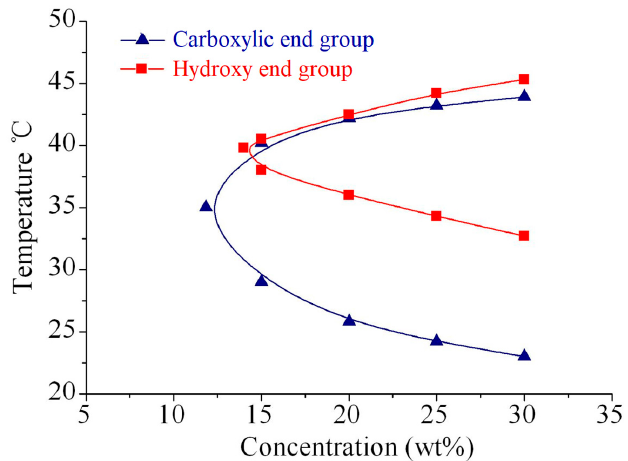
Figure 3. Phase transition curves of hydroxyl terminated and carboxylic terminated PECP copolymers.